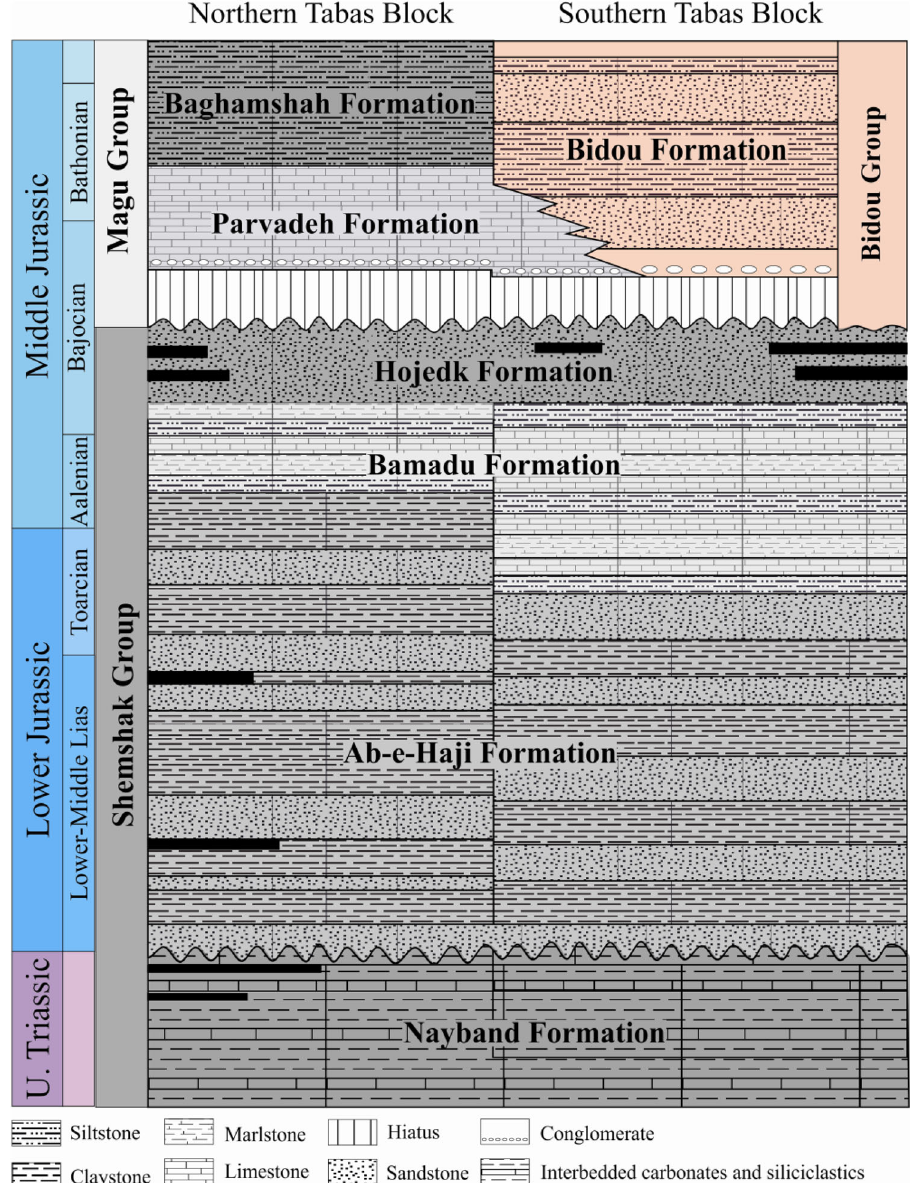
Fig. 3 Lithostratigraphy of the Upper Triassic to Middle Jurassic of the Tabas Block (northern and southern part). Modified after Wilmsen et al.